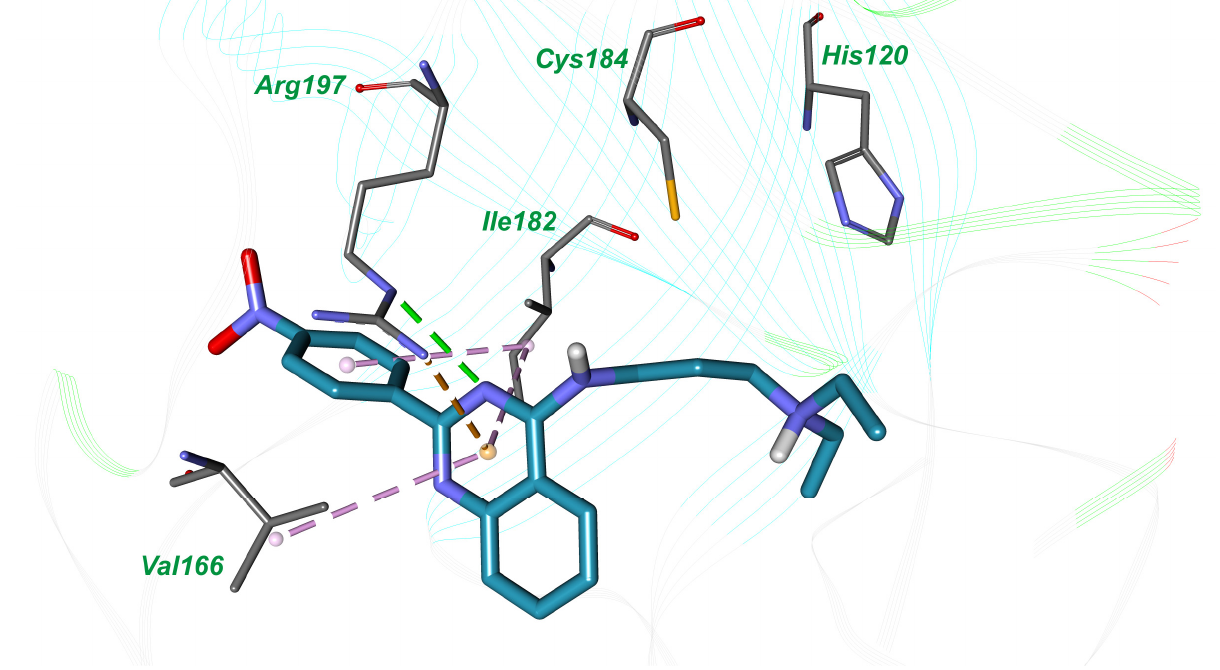
Figure 2. The binding mode of compound 1 in the active site of S. aureus sortase A; hydrogen bond is shown by the green dotted line, hydrophobic interactions are indicated by the magenta dotted lines and π -cation interaction is presented by orange dotted line.